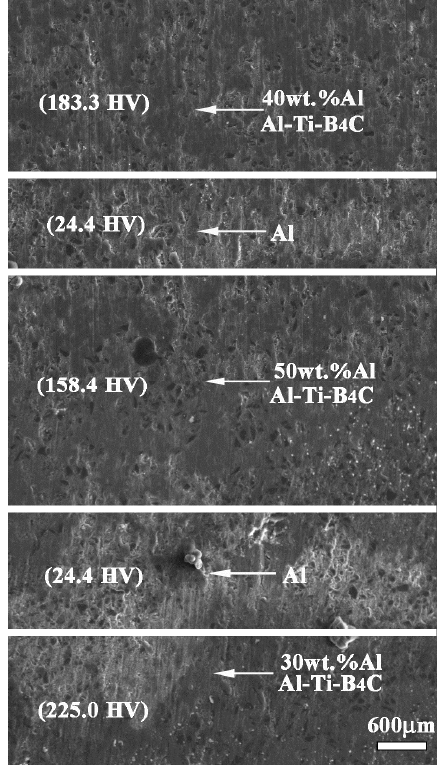
Figure 3. Metallography and microhardness of bionic layered composite.